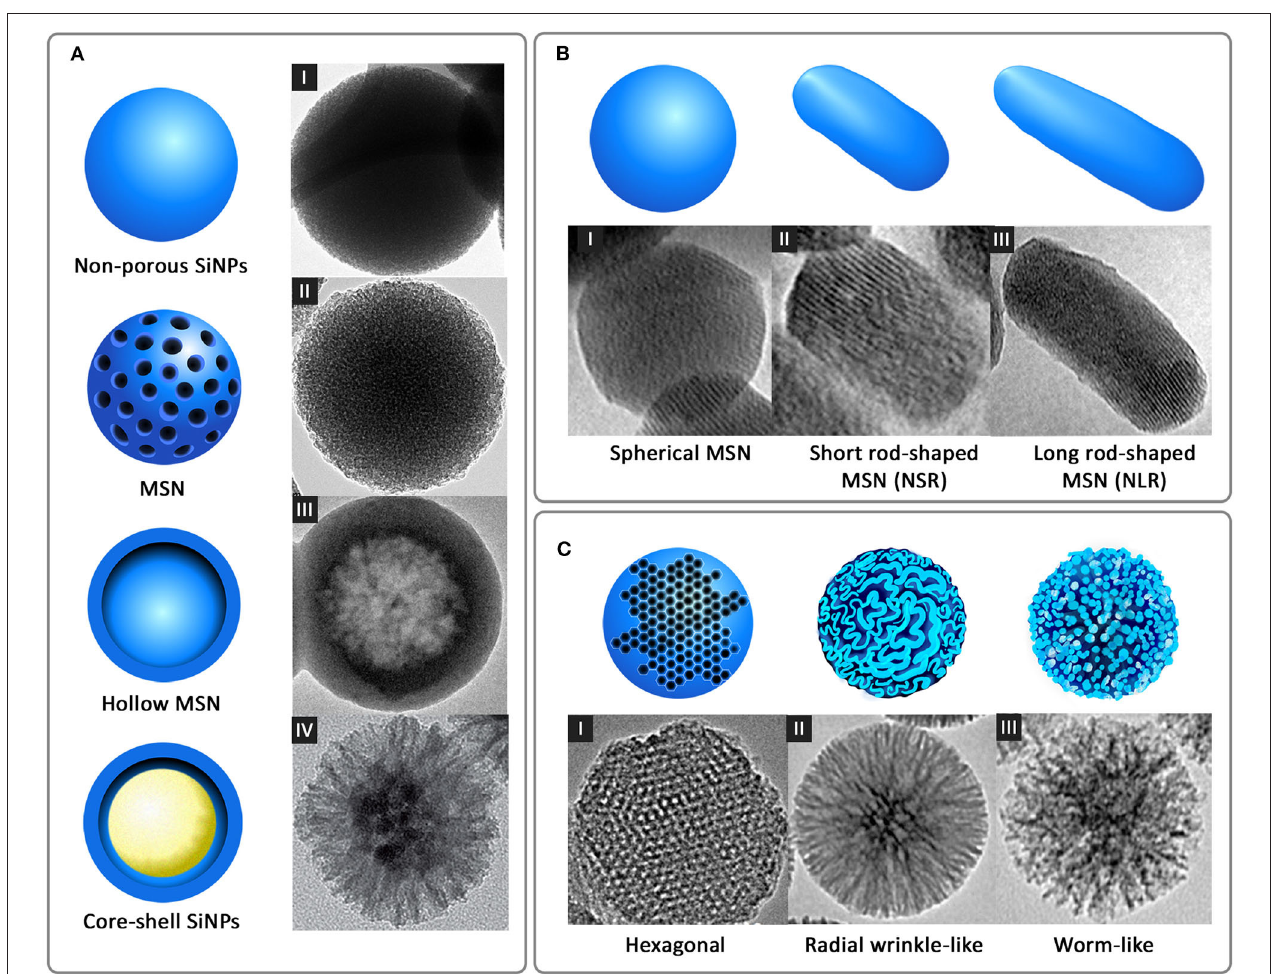
FIGURE 2 | Different forms of silica nanoparticles based on (A) Structural morphology: I-non-porous SiNPs, II-MSN, III-hollow MSN [reprinted with permission from Springer Nature Limited 2017 © (Bao et al., 2017)], and IV-core-shell SiNPs [reprinted with permission from WILEY-VCH Verlag GmbH & Co. KGaA, Weinheim 2016 © ( Xiong et al., 2016)] (B) Shape: I-spherical MSN, II-short rod-shaped MSN (NSR), and III-long rod-shaped MSN (NLR) [reprinted with permission from Springer Nature Limited 2017 © ( Zhao et al., 2017)] and (C) Pore morphology: I-ordered hexagonal [reproduced with permission from SAGE Publications Ltd 2014 © (Huang et al., 2014)], II-radial wrinkle-like [reprinted with permission from American Chemical Society 2012 © (Moon and Lee, 2012)], and III-worm-like [reproduced with permission from American Chemical Society 2013 © ( Zhang et al.,